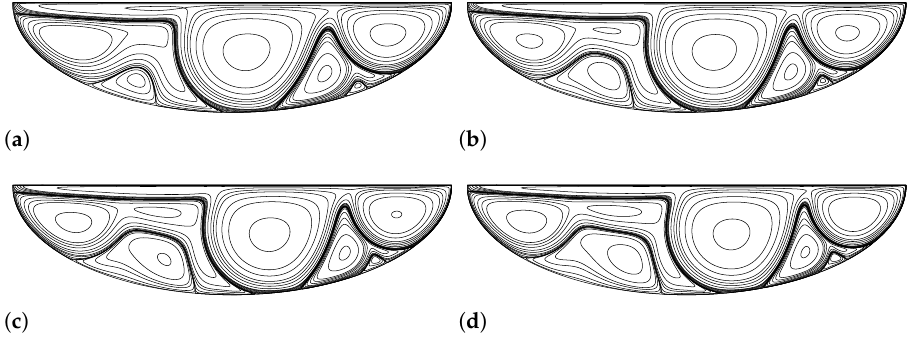
Figure 7. The evolution of the 2nd solution of driven semi-elliptical cavity flow above Re = 14,000 for D = 0.5 aspect ratio. ( a ) Re = 15,000 (2nd solution). ( b ) Re = 20,000 (2nd solution). ( c ) Re = 25,000 (2nd solution). ( d ) Re = 30,000 (2nd